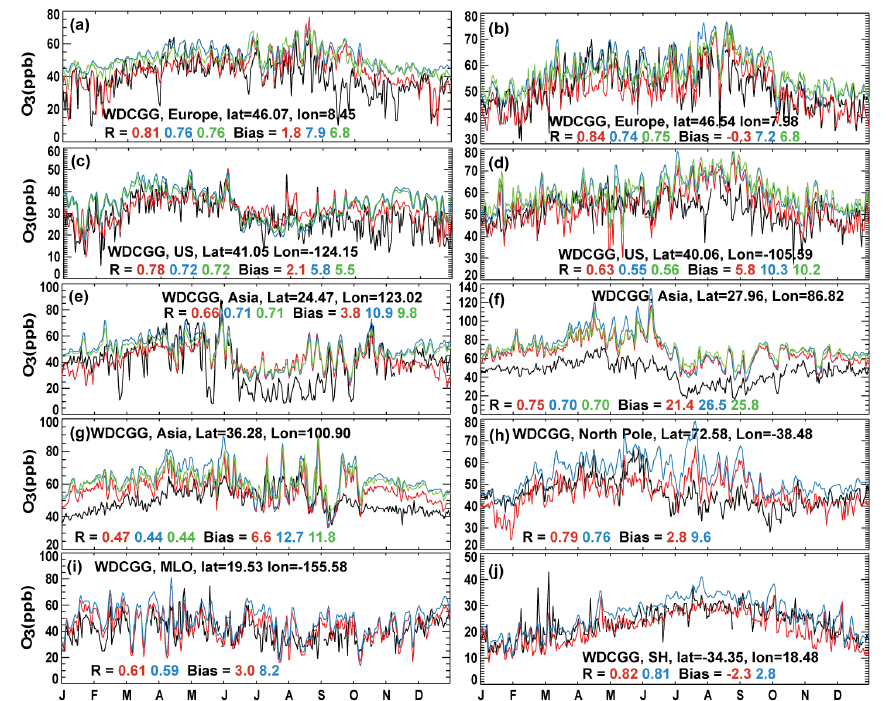
Figure 5. Day-to-day time series of afternoon (12:00–18:00LT) mean surface ozone observed at 12 background sites from WDCGG (black lines) and coincident model simulations (red lines for two-way simulations, blue lines for global model alone and green lines for one-way nested simulations). Also shown in each panel are latitude, longitude and model correlation with and bias against the observations.